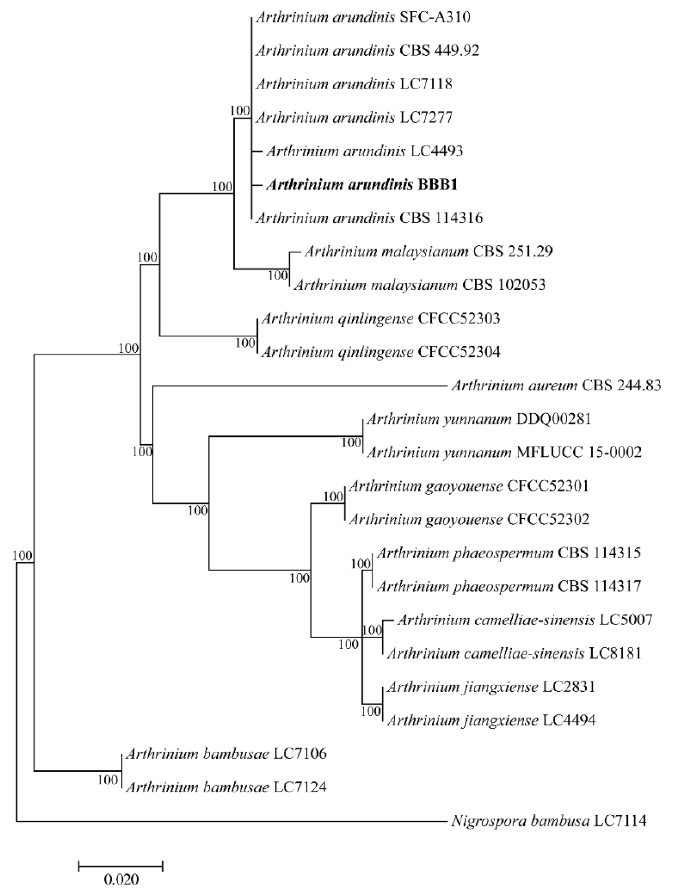
Figure 4. The phylogenetic tree of the isolate BBB1 with allied taxa analyzed using concatenated sequences of ITS, TEF1- α , and TUB2 with the maximum likelihood method. Nigrospora bambusa was used as the outgroup.